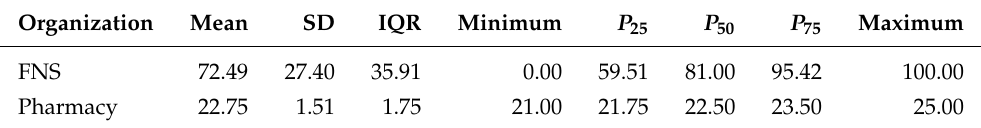
Table 4. Descriptive statistics for saving of inventory cost (in %) by organization.